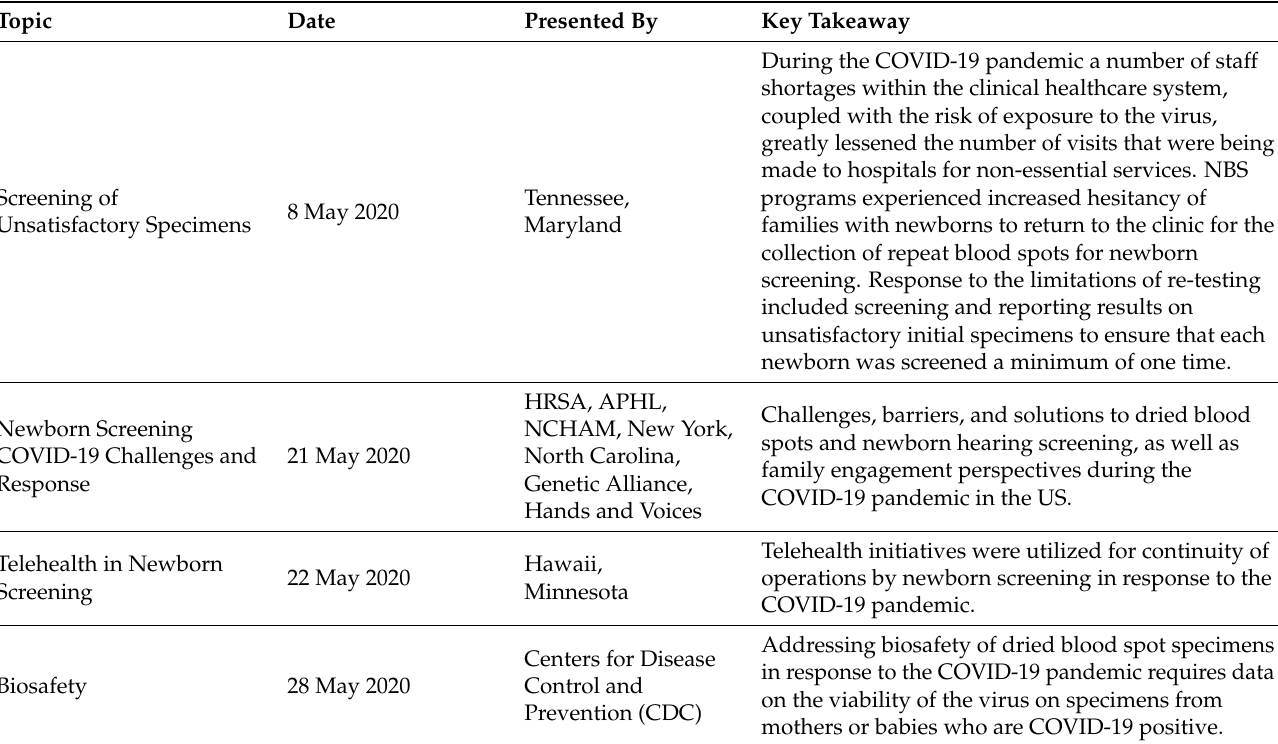
Table 2. COVID-19 and newborn screening topical webinars hosted by